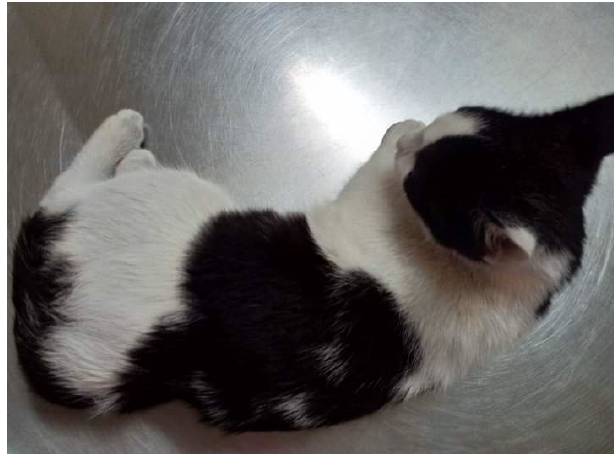
Figure 1. A concave back of a kitten (case 1)